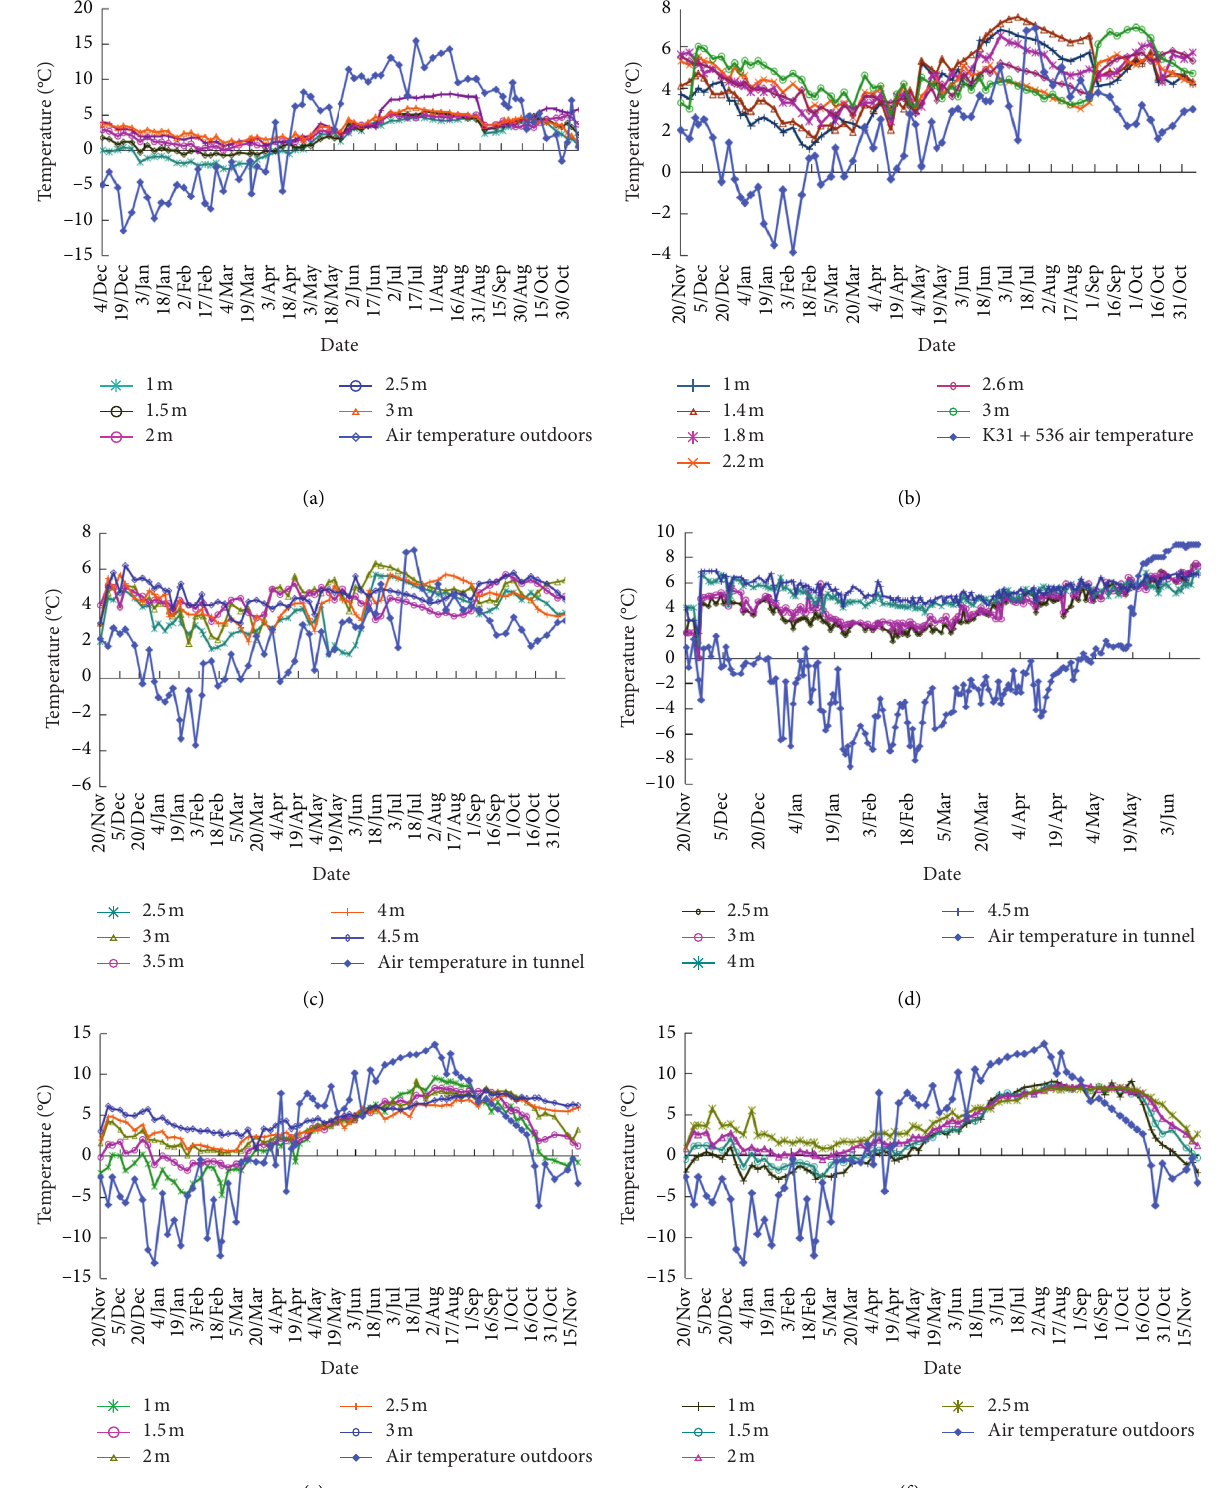
Figure 8: The ground temperature curves at different locations and testing sections vs. time. (a) Section K30+663. (b) Section K31+ 536. (c) Section K31+668. (d) Section K33+218. (e) Section K33+970. (f) Section K33+